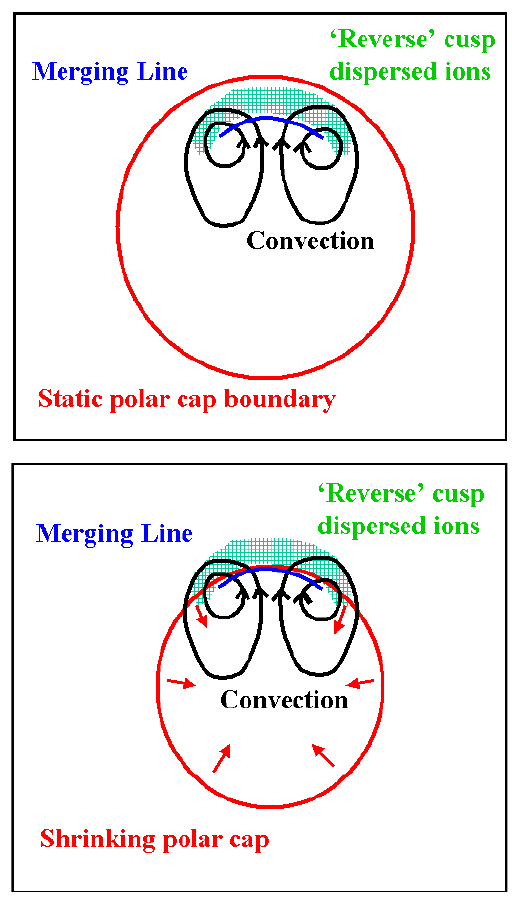
Fig. 1. Schematic diagrams showing the relationship between the polar cap boundary (red circle), the ionospheric projection of the merging line (blue arc), the reverse ionospheric convection cells (black curves), and the reverse cusp ion dispersion region (shaded green region) for two possible reconnection scenarios during an in- terval of northward IMF. ( a ) Reconnection on a particular magne- tosheath field line occurs in one hemisphere only. ( b ) Reconnection on a particular magnetosheath field line occurs in both hemispheres